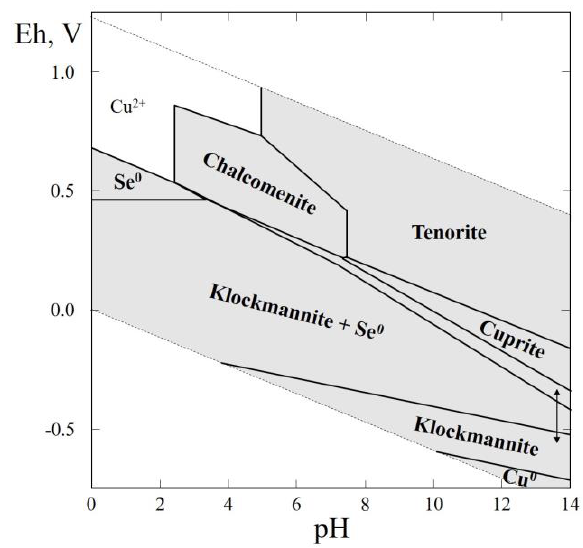
Figure 5. Eh – pH diagram of the OHSeCu (Cu – Se – H 2 O) system at 25 °C and the activities of the components: a ΣSe = 10 − 4 , a ΣCu = 10 − 2 .